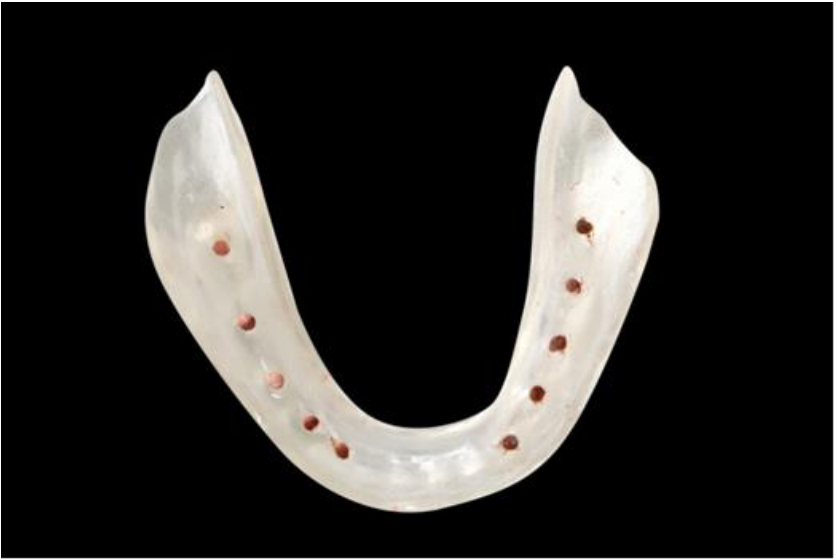
Figure 3. Diagnostic stent made of self cure acrylic with channels filled with gutta-percha.